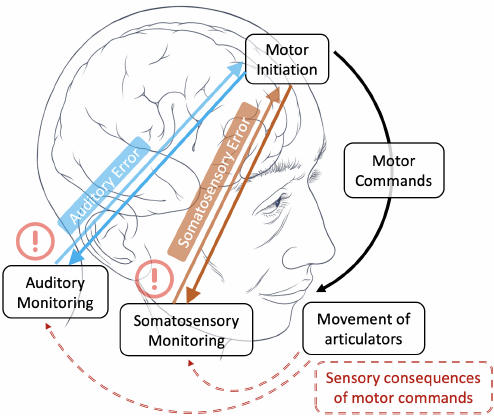
Figure 1. Sensorimotor systems involved in speech (adapted here from